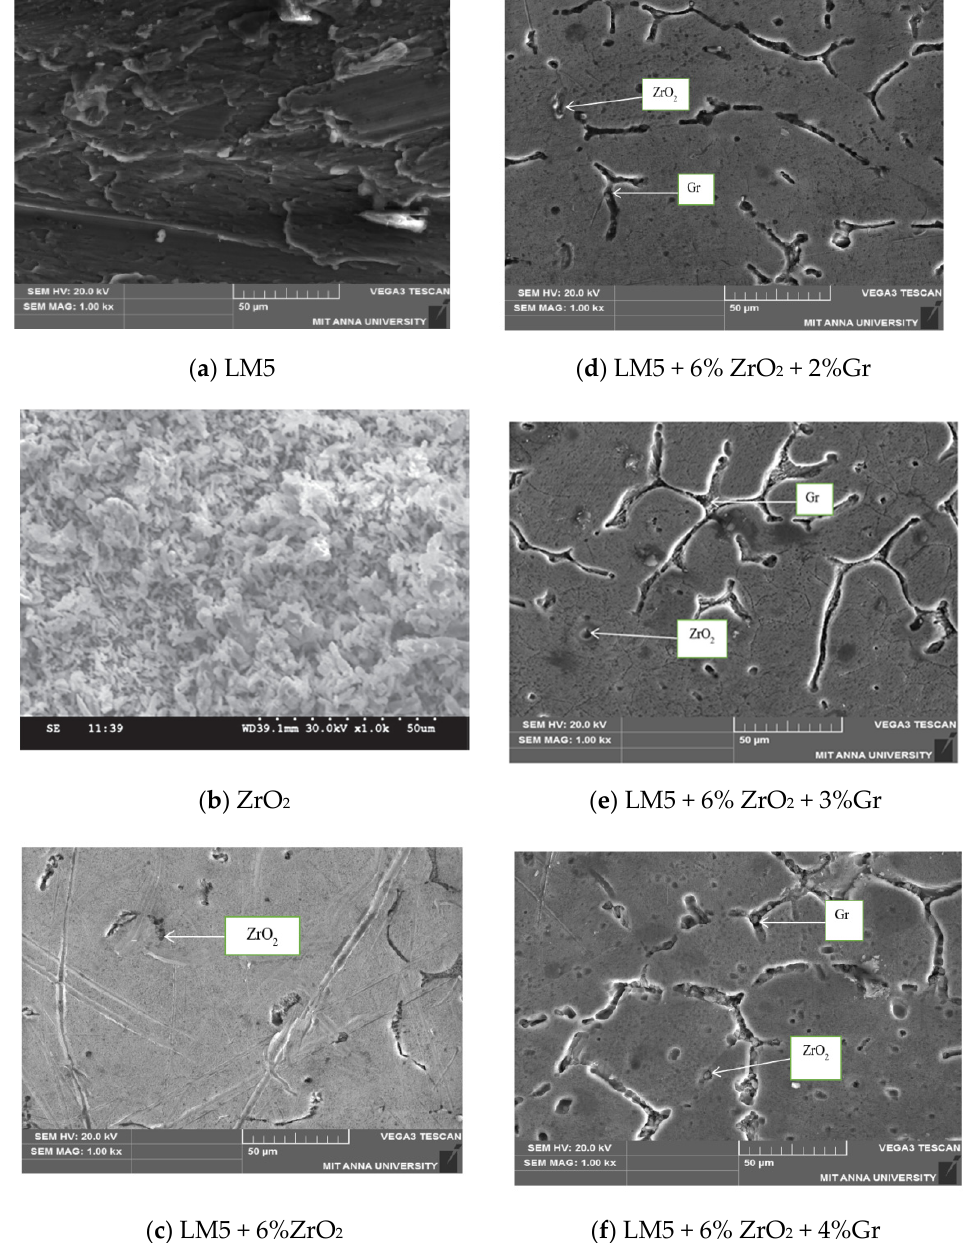
Figure 6. SEM images of hybrid